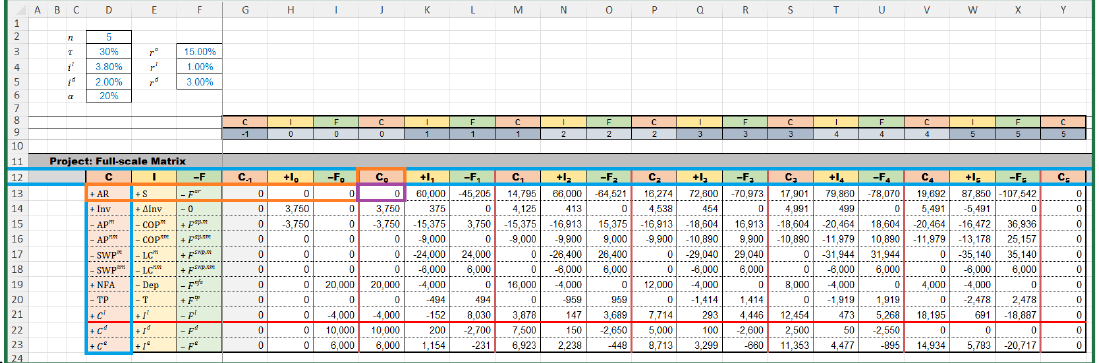
Figure 38. Cell J13 contains the value that has the same row-label as SiglePeriod!D7 ( +AR ) and the same column-label as SiglePeriod!I4 ( 𝐶 (cid:2868) ) (“SplitScreenStrip” sheet).